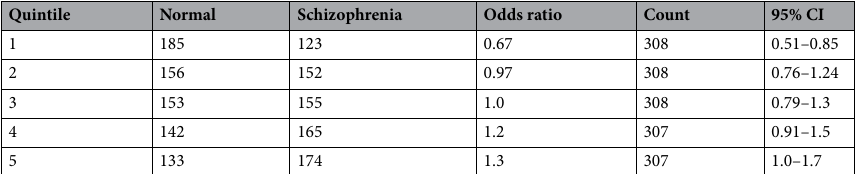
Table 2. This table represents the odds ratio between the quintiles of predicted results from our cross- validated results. The result indicates that the top quintile is twice as likely to have an accurate prediction for Schizophrenia as the bottom